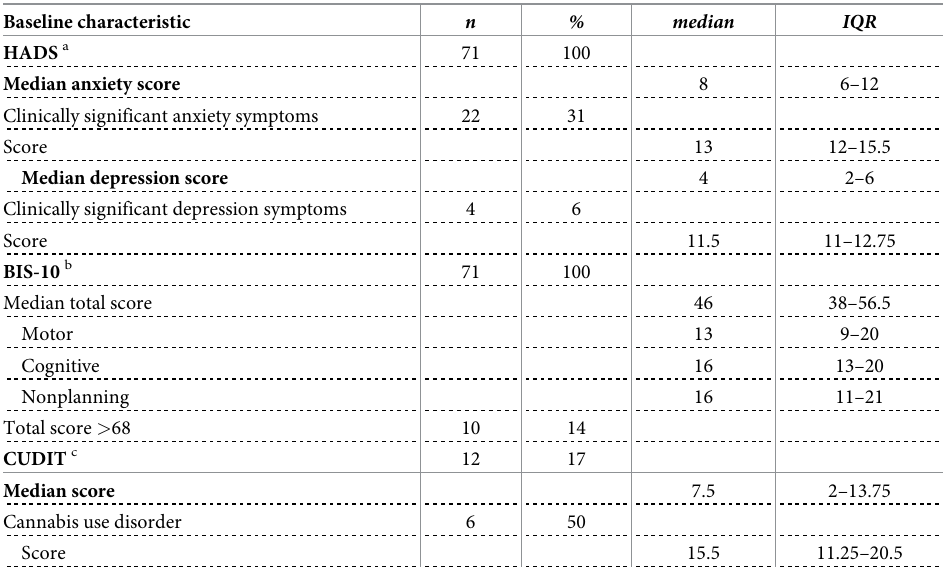
a Values range from 0 to 21 with values � 11 denoting clinically significant anxiety or depression symptoms. b Values range from 0 to 136 (higher score denotes higher level of impulsiveness); 68 is the median value of the scale. c Values range from 0 to 40, with values � 8 indicating cannabis use